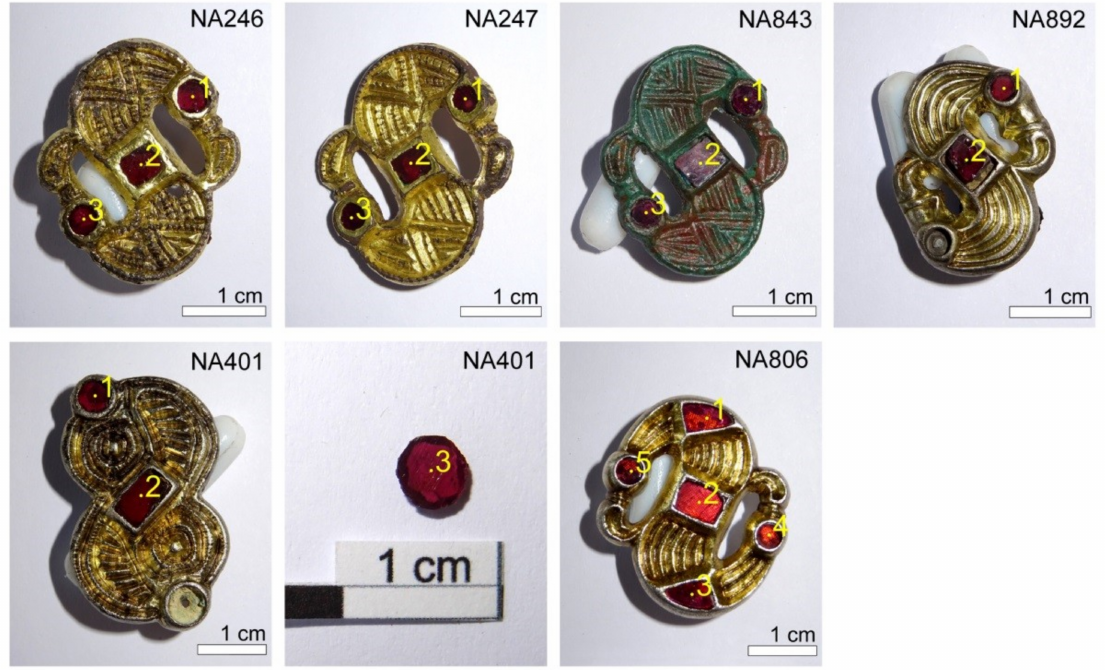
Figure 2. Investigated S-fibulae from the archaeological site at Lajh (Kranj, Slovenia) with labelled